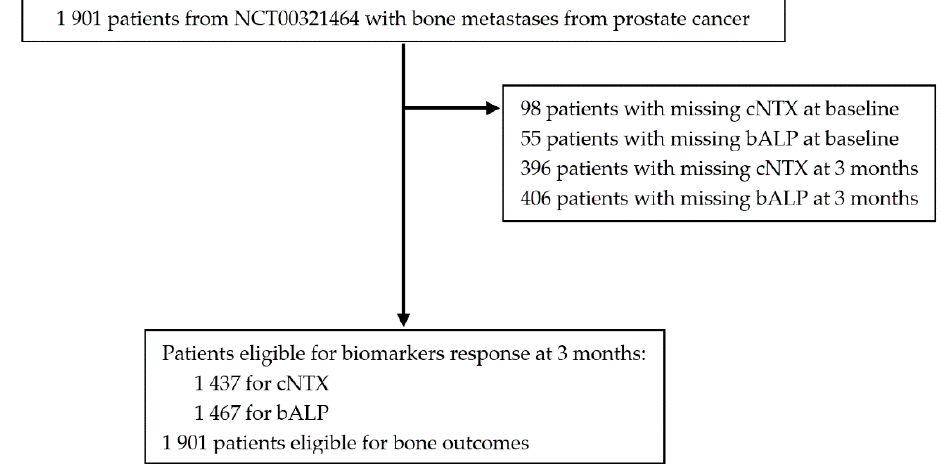
Figure 4. Consort study flowchart. bALP, bone alkaline phosphatase; BPI, Brief Pain Score; cNTX, corrected N-terminal telopeptide.